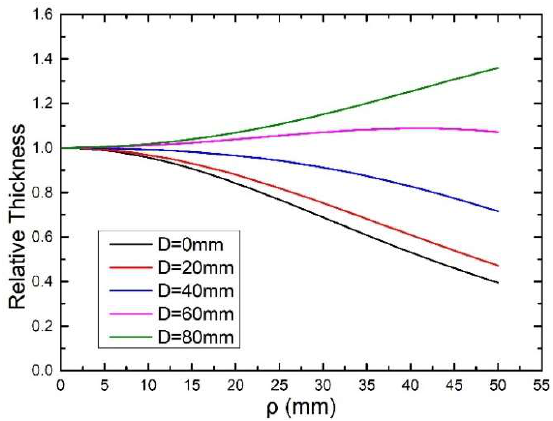
Figure 20. Relative film thickness distribution of D = 0, 20, 40, 60, 80 mm, ρ from 0 to 50 mm.